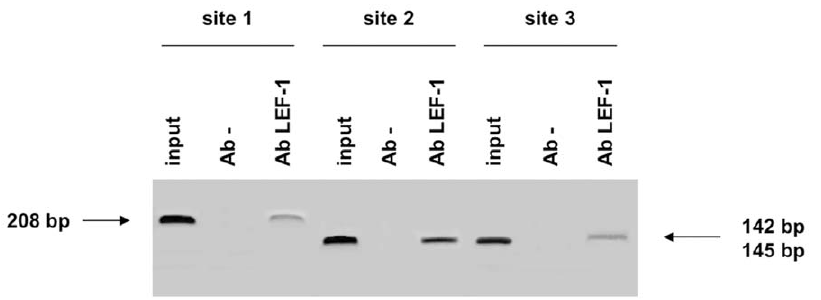
Figure 3. Binding of LEF-1 to the 1.6-kb IDO1 promoter. PCR products were obtained from immunoprecipitates after ChIP assays of HeLa cells and loaded on a ethidium bromide stained-1% agarose gel. Three specific oligonucleotide primer pairs were used to confirm the presence of the three potential LEF-1/TCF binding sites on the 1.6 kb IDO1 promoter region, as predicted by MatInspector. The three corresponding amplicons are sized 208 bp (site 1), 145 bp (site 2) and 142 bp (site 3). Positive controls (Input chromatin DNA before immunoprecipitation), negative controls without antibody (Ab-) and immunoprecipitation with anti-LEF-1 antibody are indicated for each amplified fragment of the IDO1 promoter. Site 1 refers to the putative LEF-1 binding site within the 24-bp motif of the VNTR; sites 2 and 3 refer to the two additional LEF-1 sites predicted by MatInspector.